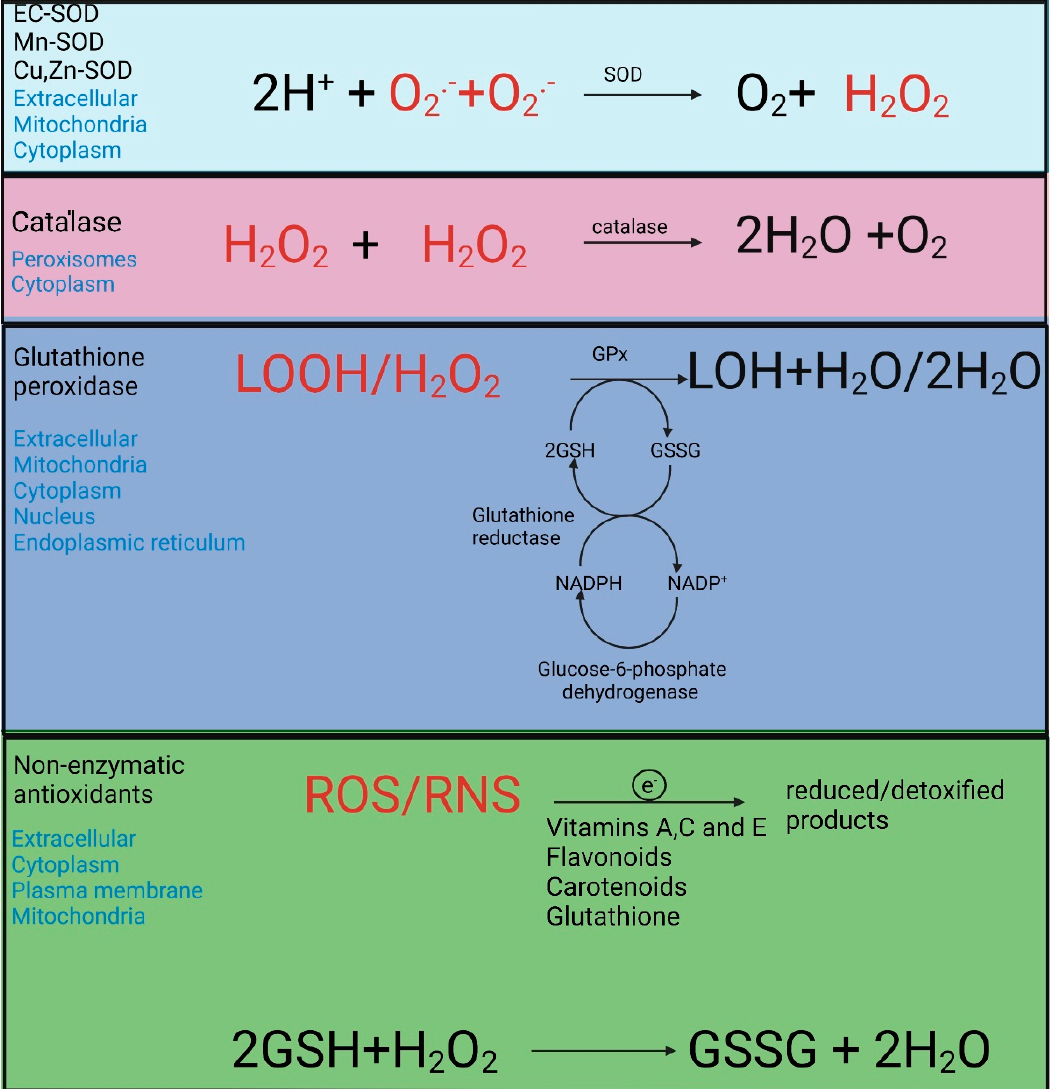
Figure 5. The antioxidant system in cells. ROS and RNS are neutralized by enzymatic and non- enzymatic antioxidants, which catalyze the degradation of these reactive species by transferring electrons to them (antioxidants are also named “electron donors”). The enzymatic antioxidants catalyze reactions that degrade the respective ROS or RNS. Thus, the superoxide dismutase (SOD) dismutases the O 2· − to H 2 O 2 and O 2 . Catalase and glutathione peroxidase (GPx) converts H 2 O 2 to H 2 O (and oxygen in the case of catalase). The GPx also converts LOOH to lipid alcohols (LOH) and H 2 O 2 . The glutathione reductase (GR) restores GSH pools from oxidized glutathione (GSSG) using NADPH as reducing equivalents. The non-enzymatic antioxidants, such as vitamins, flavonoids, and glutathione, can also reduce and degrade ROS and RNS by transferring electrons to them. Cu, Copper; Cu, Zn-SOD, copper, zinc superoxide dismutase; EC, extracellular; EC-SOD- extracellular superoxide dismutase; GPx, glutathione peroxidase; GSH, glutathione; GSSG, glutathione disulfide; H 2 O 2 hydrogen peroxide; H 2 O, water; LOH, lipid alcohols; LOOH, lipid hydroperoxides; Mn, manganese; Mn-SOD, manganese superoxide dismutase; NADPH, nicotinamide adenine dinucleotide phosphate; O 2· − , s superoxide anion radical; RNS, reactive nitrogen species ROS, reactive oxygen species. The figure is redrawn with Biorender from reference [39] with permission (License Number 5484750703800). Copyright © 2017, Springer International Publishing AG.